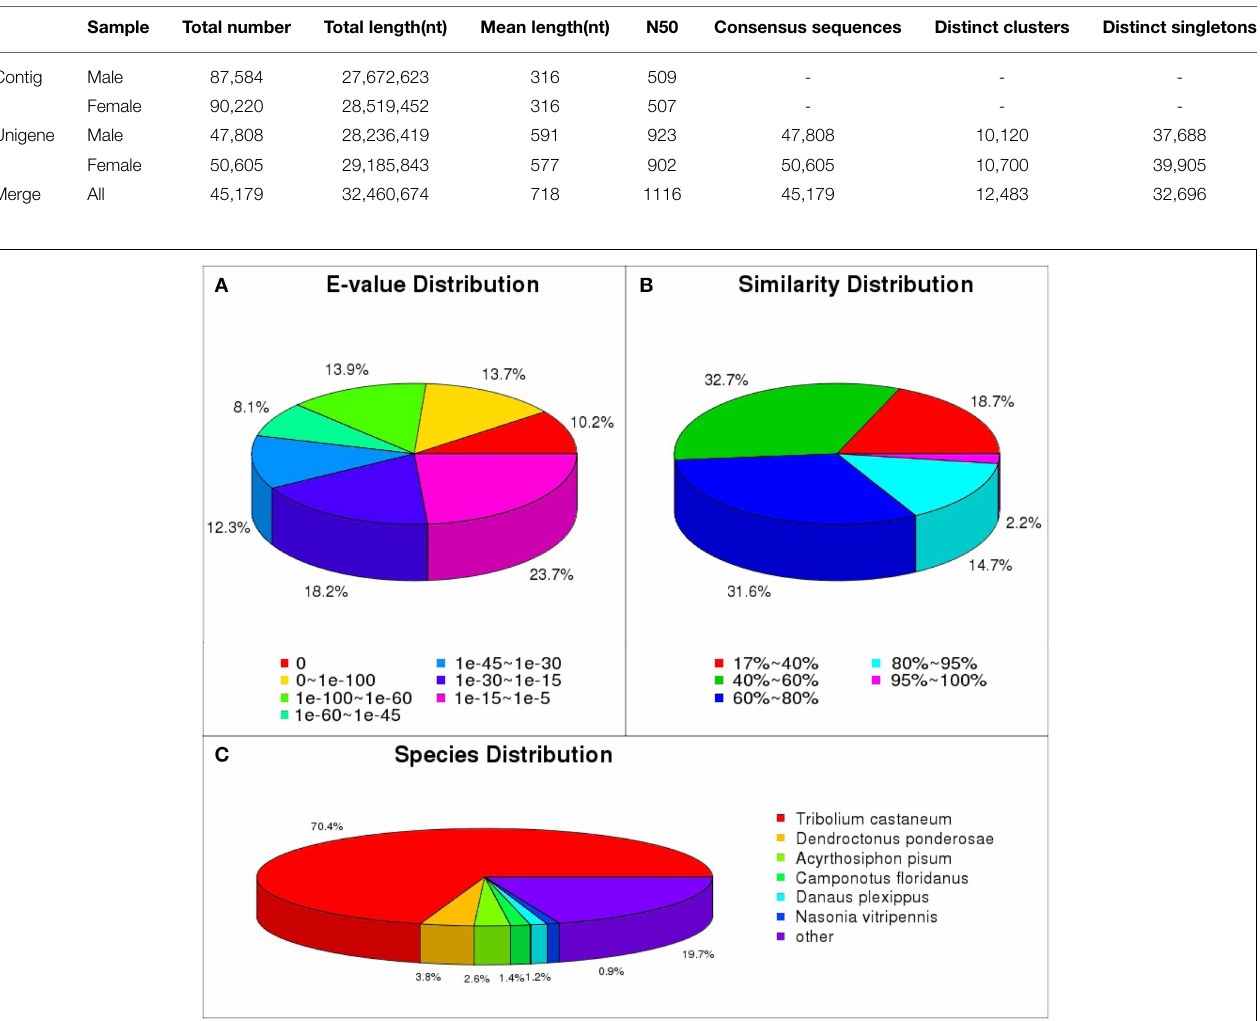
TABLE 1 | Assembly summary of L. decemlineata antennal transcriptome.